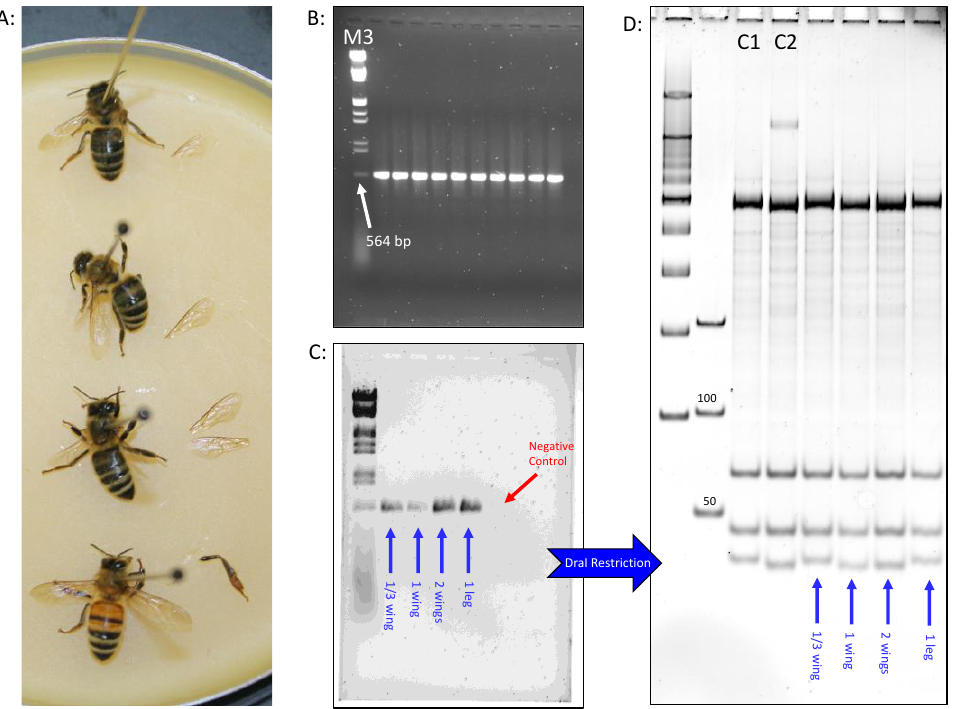
Figure 1. Outcome of the mtDNA genetic analysis conducted on various worker honey bees’ tissues. ( A ): a dissection of one-third, one and two wings, as well as one leg. ( B ): electrophoresis on 1.5% agarose gel of an optimal series of COI-COII PCR amplificons. ( C ): Same as ( B ) but for the studied tissues of ( A ). ( D ): Polymorphisms of the enzymatic restriction conducted on one-third, one, and two wings and one worker leg revealed on 7.5% polyacrylamide gel. The first four wells are two ladders and two reference haplotypes C1 and C2 which characterize ligustica and carnica subspecies, respectively.